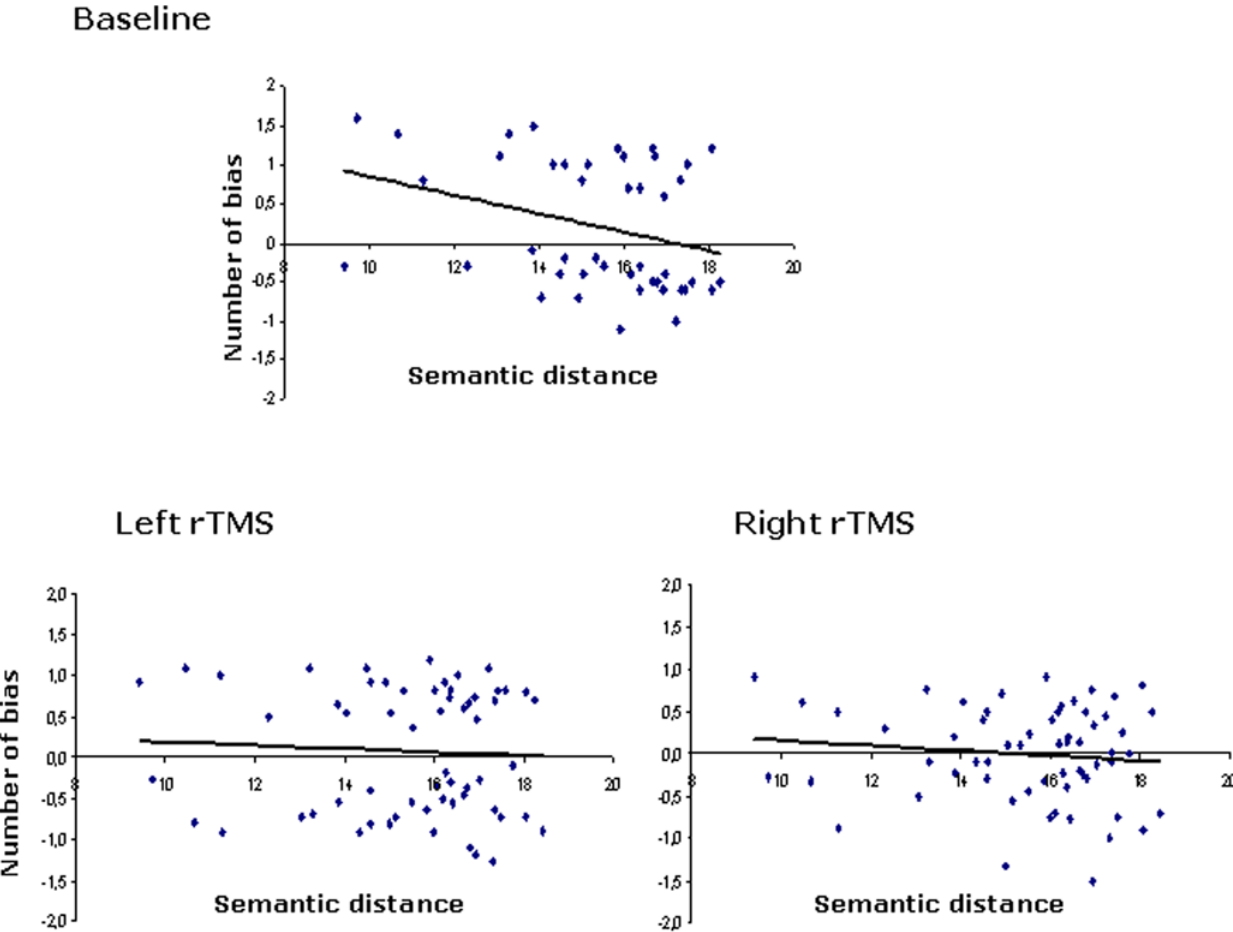
Figure 6. Bias in Experiment 1 (top panel) and Experiment 5 (bottom panel) as a function of semantic distance. In Experiment 1, rightward bias in the Semantic distance judgment task decreased as the magnitude of the semantic distance increased (top panel); in Experiment 5 (bottom panel), left parietal rTMS disrupted the correlation between rightward bias and semantic distance, whereas right parietal rTMS did not affect this correlation.